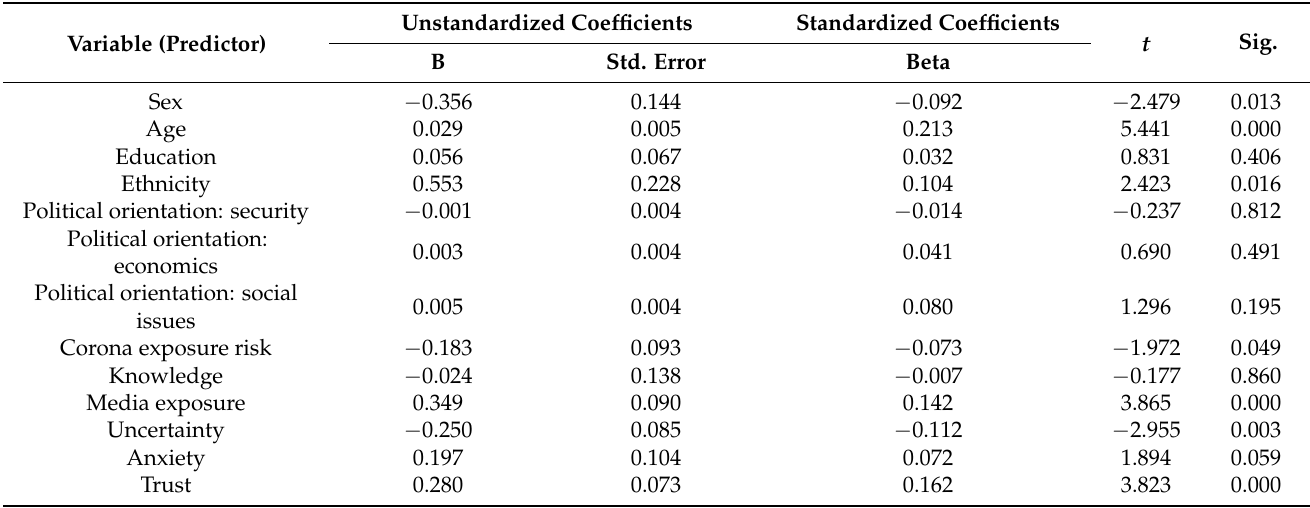
Table 4. Regression analysis of the probable predictors separately, controlling the effect of other factors (R 2 = 0.151, adjusted R 2 = 0.121, F change = 2.042).